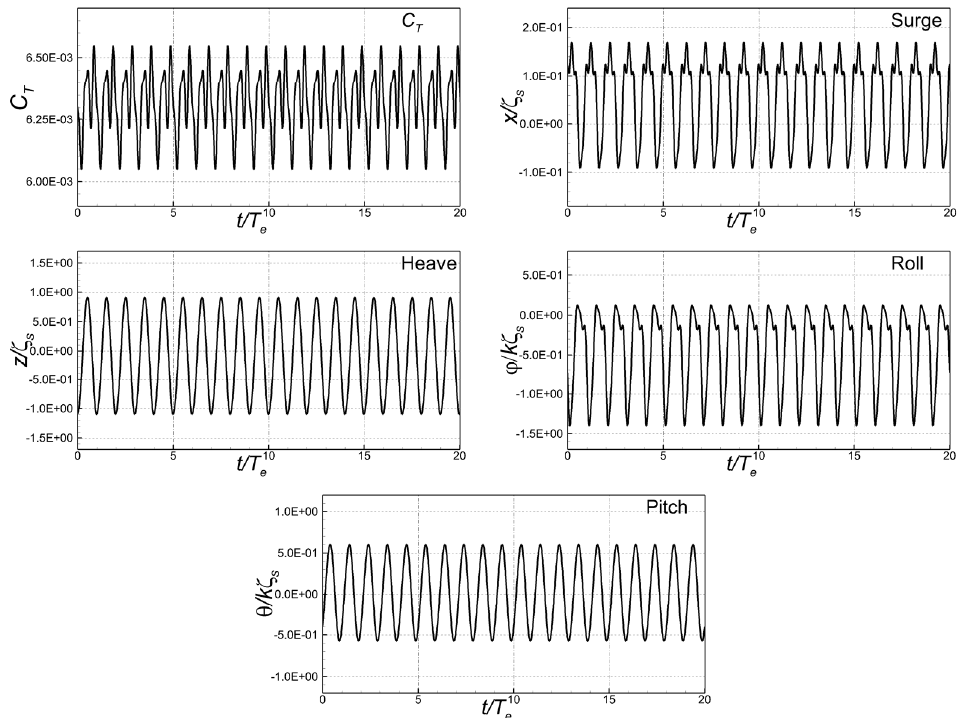
Figure 17. Time histories of the Fourier reconstructed resistance coefficient ( C T ) , surge ( x ) , heave ( z ) , roll ( ϕ ) and pitch ( θ ) for the FRxz ϕθ bow waves scenario.